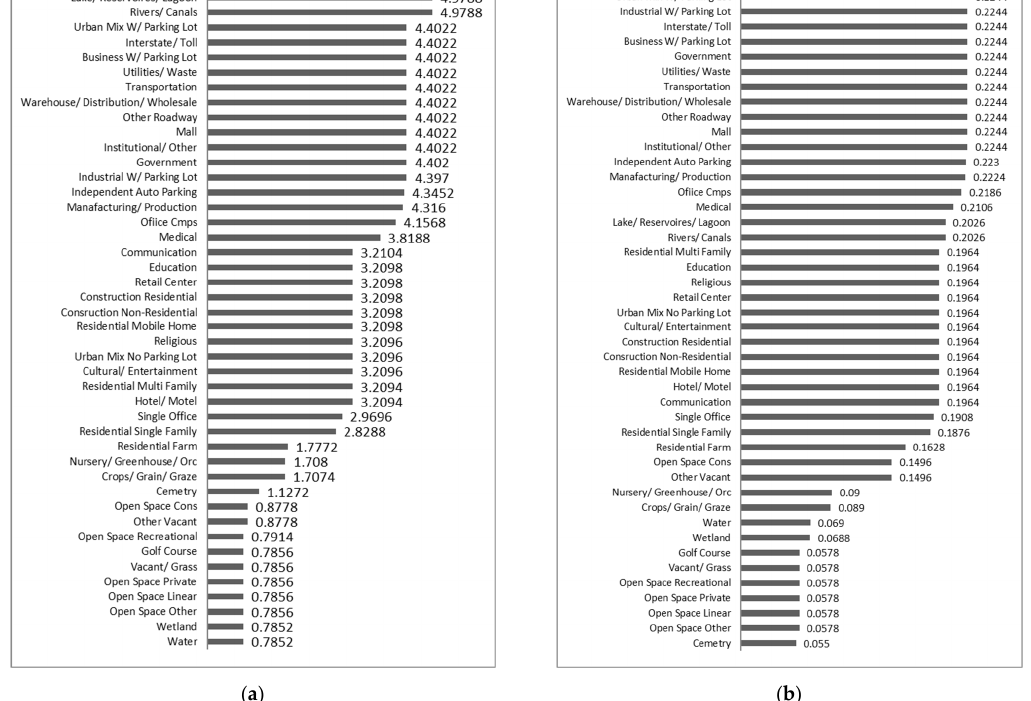
Figure 7. Average EC for ( a ) total nitrogen and ( b ) total phosphorous (lbs/acre/yr.).